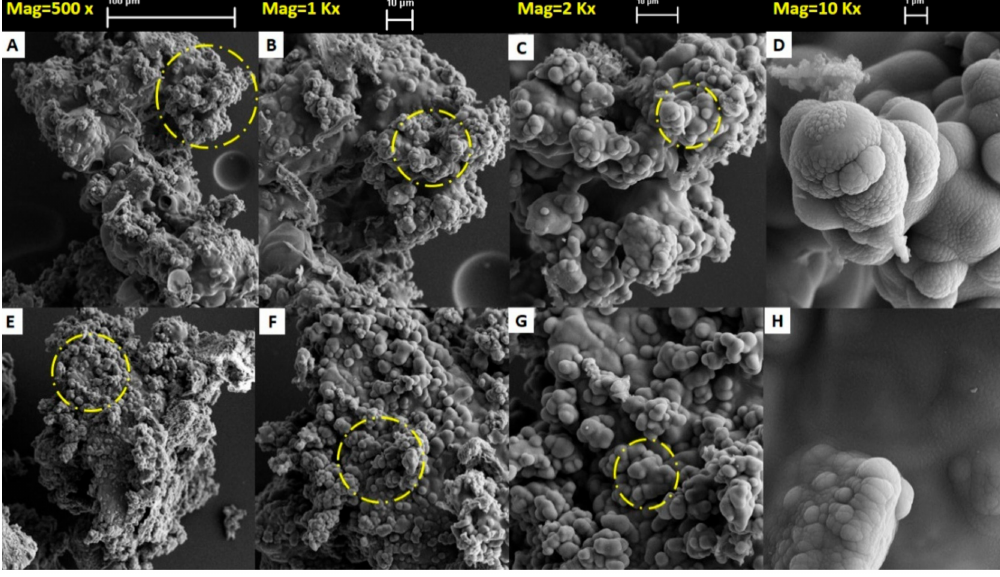
Figure 4. SEM image of particle distribution and surface morphology from Bio50-CO 2 water washed at 600 ◦ C ( A – D ) Example particle at increasing magnification ( E – H ) additional particle at increasing